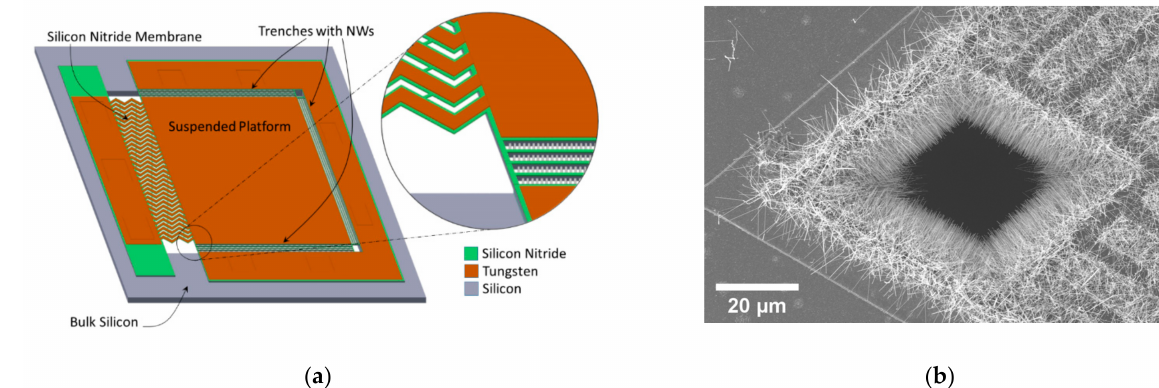
Figure 1. ( a ) Sketch of the fabricated devices consisting of a suspended (typically 1 mm 2 ) platform connected to the bulk part of the device by a thin structured nitride membrane on top of which the metal leg is placed, and by Si-based nanowires (NWs) along the other three sides of the platform. In these regions, the NWs bridge a given number of 10 µ m wide trenches (from 1 to 4 in the current design) defined by micromachined vertical Si walls. These Si-based NWs arrays configure the laterally extended nanostructured semiconductor leg of the thermocouple; ( b ) SEM image of the device corner opposite the membrane where grown dense arrays of nanowires can be appreciated bridging the trenches and growing freely inside the corner